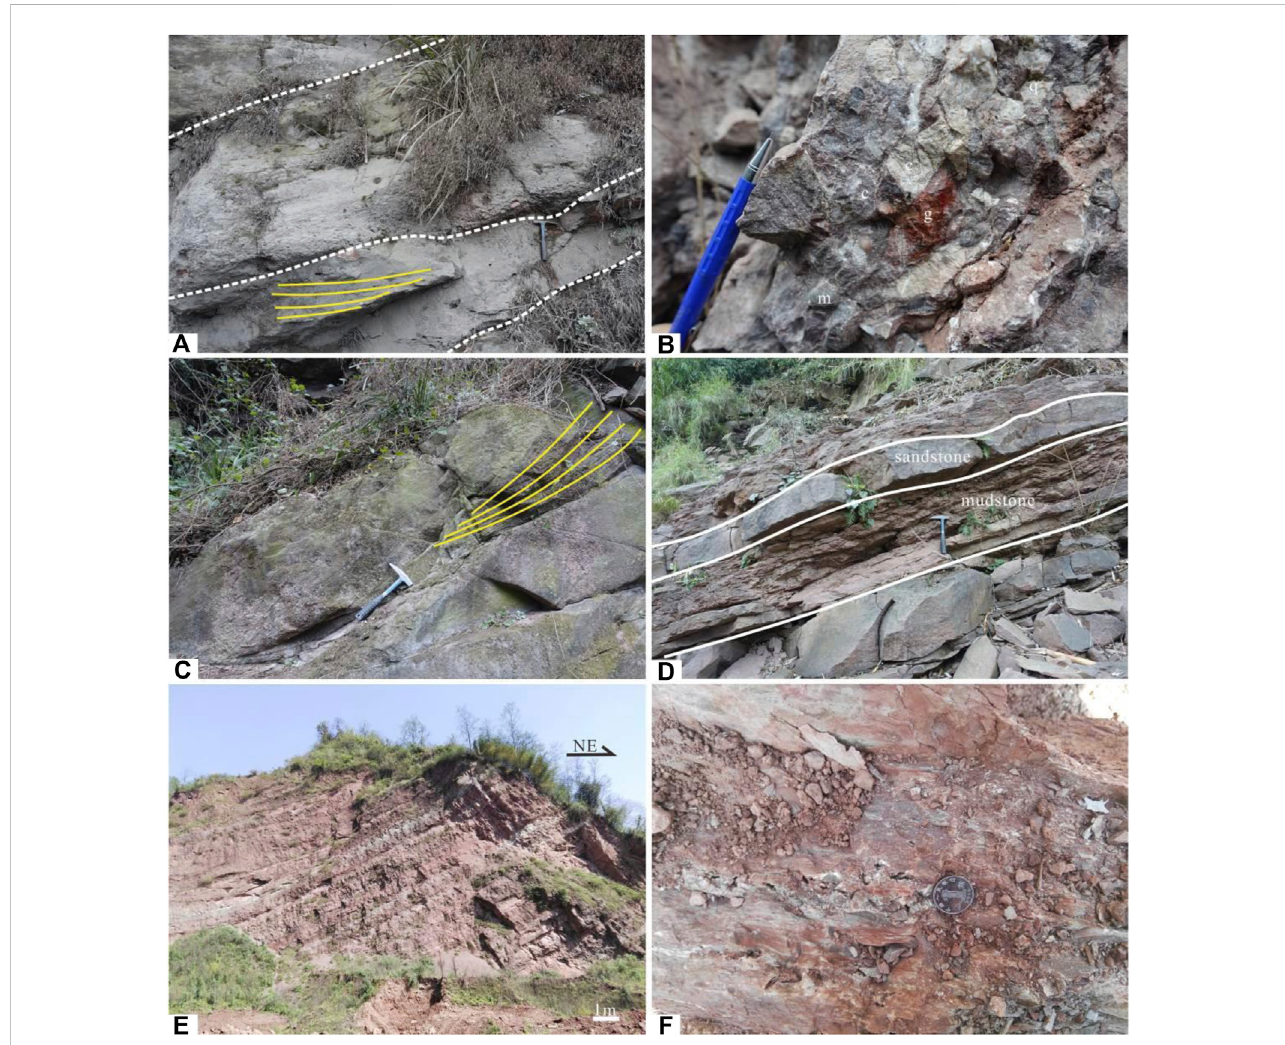
FIGURE 4 Typical outcrops photographs from the Feixianguan section. (A) Channel bottom scour surface and conglomerate in the Tianmashan Formation. (B) Basal conglomerate in the Jiaguan Formation. (C) Massive medium-coarse sandstone with low-angle oblique bedding, Jiaguan Formation. (D) Interbedded sandstone and mudstone at the top of the Jiaguan Formation. (E) Brownish red lacustrine mudstone of Guankou Formation. (F) Brownish red mudstone with dissolved pores in the Guankou Formation. c-Limestone clast. m- Metasandstone clast. g- Granite